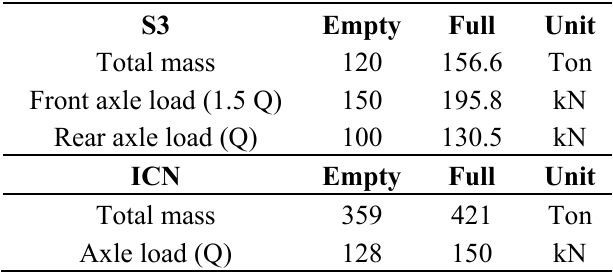
Table 1. Mass and axle load for each train with different passenger occupancy